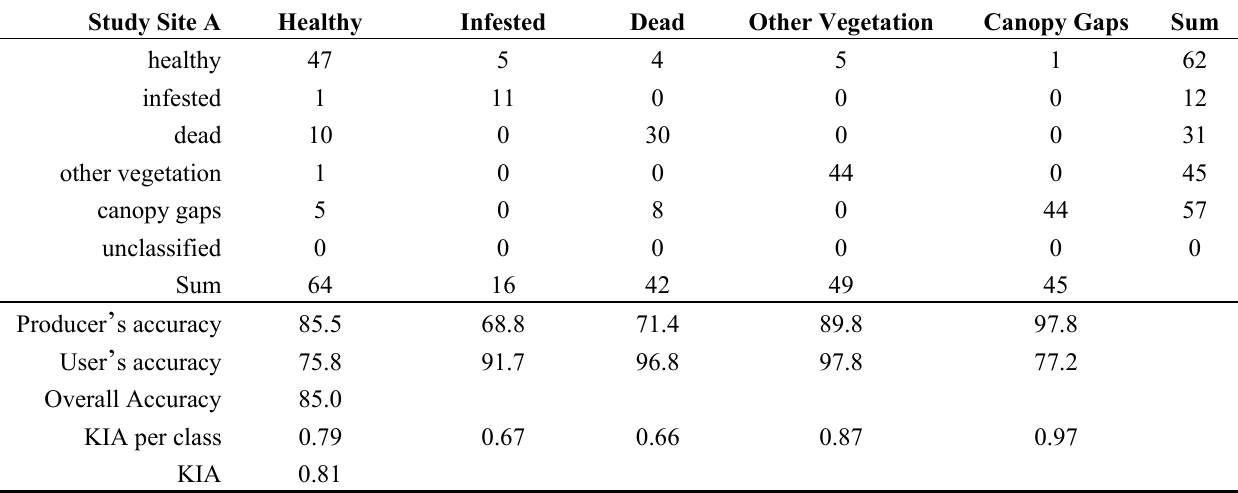
Figure 6. Classification maps of study site A ( left ) and B ( right ) obtained by multi-resolution segmentation and subsequent object-based classification. Infested and dead oaks (yellow cross and X) were identified by the regional forestry department (Soest-Sauerland) and recorded with a Differential Global Positioning System (DGPS). Table 3. Confusion matrix and accuracy results of the object-based image analysis (OBIA). Producer’s accuracy: ratio between correctly classified objects and reference samples within a class. User’s accuracy: ratio between correctly classified objects and the total number of samples assigned to a class. Overall accuracy: ratio between the number of all correctly classified objects and the total number of samples. Kappa Index of Agreement (KIA): measure of the proportion of agreement after removing random